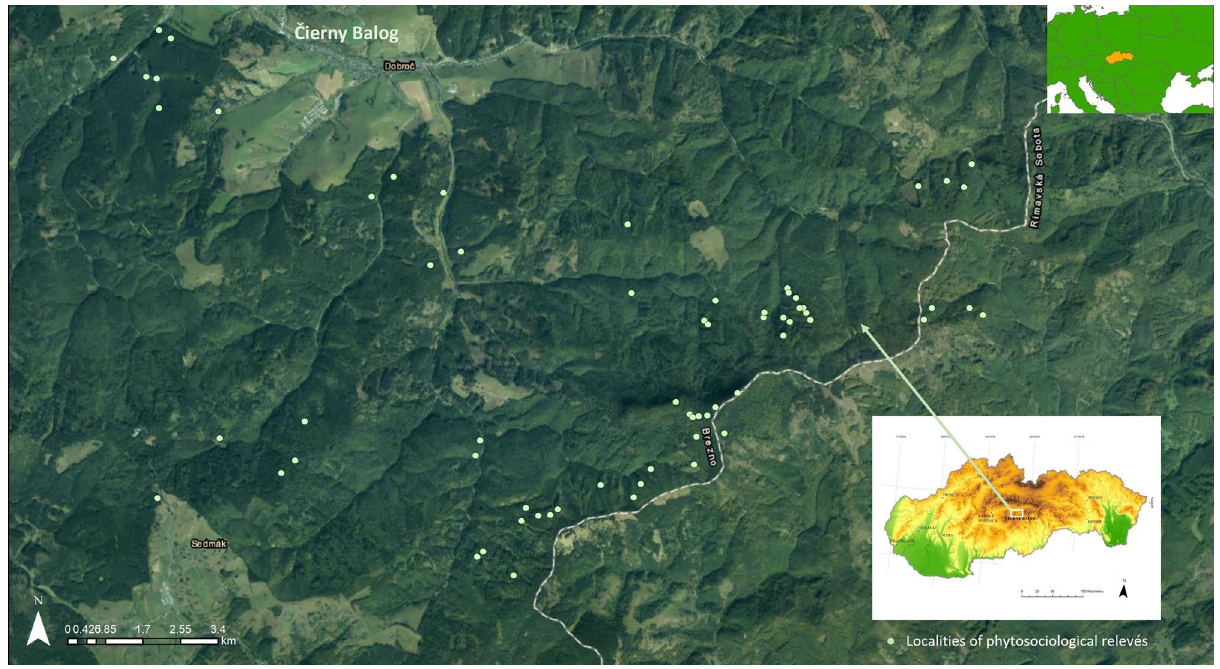
Figure 1. Localization of the case study area (created in ArcGIS ArcMap 10.4. Ortofotomozaika SR – ÚGKK ZBGIS 2021 https:// zbgis ws. skgeo desy. sk/ zbgis_ ortof oto_ wmts/ servi ce. svc/ get; data source 37